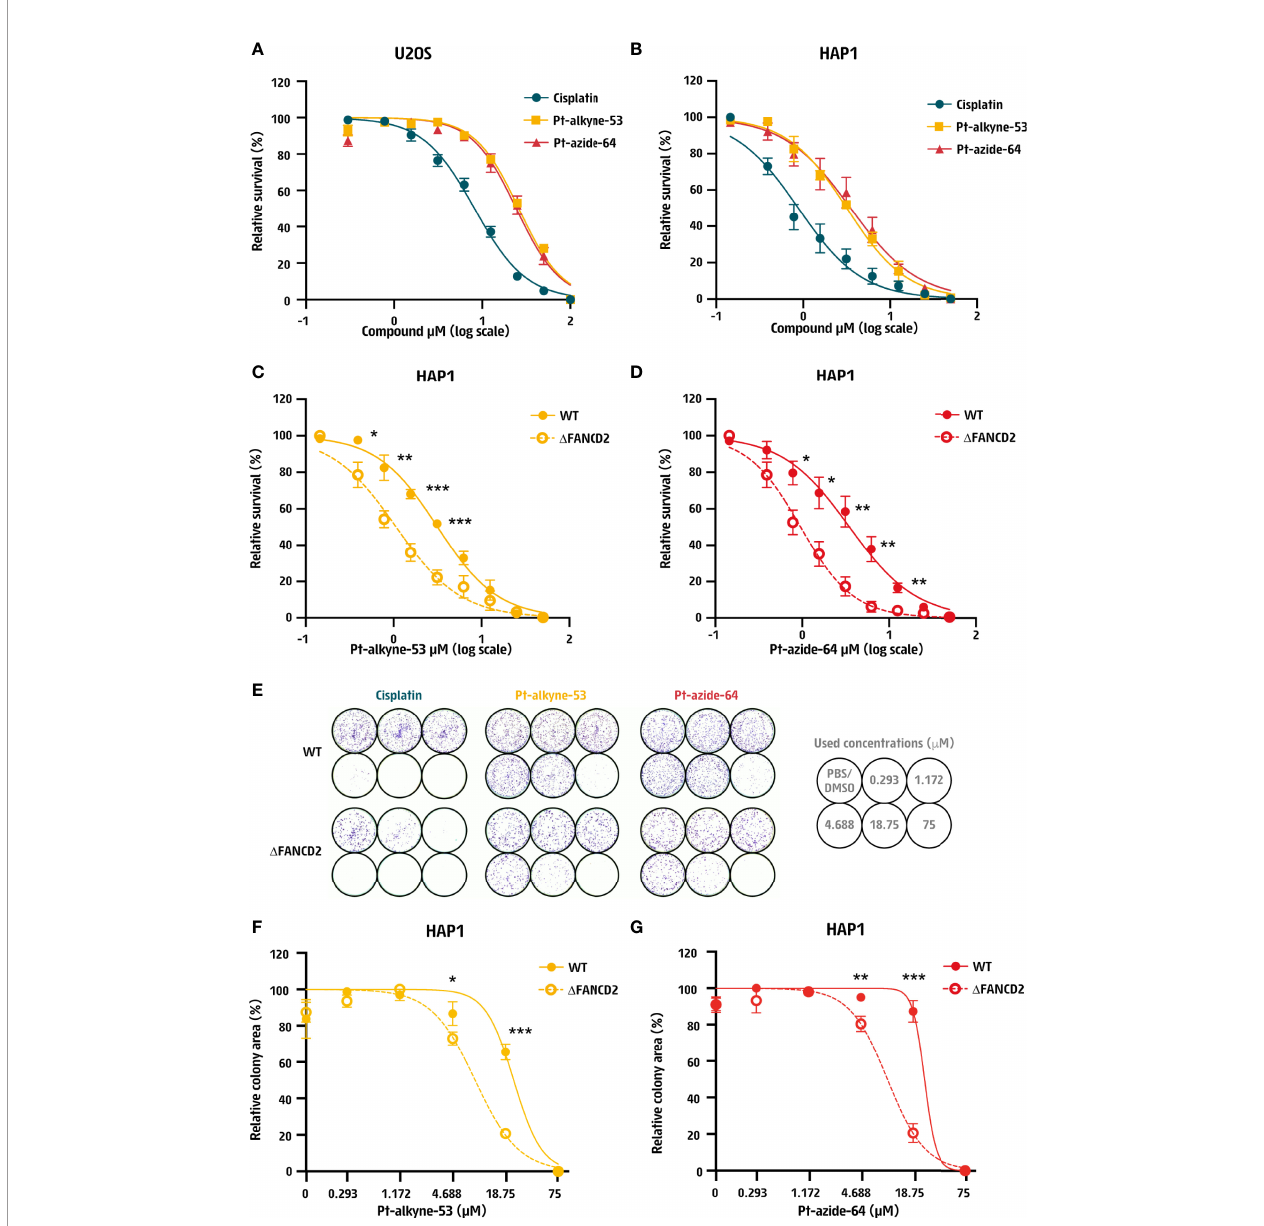
FIGURE 2 | Cisplatin derivatives confer DNA repair-dependent cytotoxicity. (A, B) Dose response curve of human (A) U2OS cells and (B) HAP1 cells treated for 3 days with cisplatin, Pt-alkyne-53 or Pt-azide-64 prepared as 2-fold serial dilutions starting at 100 m M in U2OS cells or 50 m M in HAP1 cells. Cellular survival was measured after 3 days using Cell Titer Glo ® . (C, D) Dose response curve of wildtype (WT) and FANCD2 de fi cient ( D FANCD2) HAP1 cells treated with the indicated doses of (C) Pt-alkyne-53 and (D) Pt-azide-64 for 3 days. Cellular survival was measured using Cell Titer Glo ® . Data represent mean and SEM of 3 independent experiments performed in technical duplicates. (E – G) Clonogenic assay of wildtype (WT) and FANCD2 de fi cient ( D FANCD2) HAP1 cells treated with the indicated doses of cisplatin, Pt-alkyne-53 and Pt-azide-64 for 7-8 days. (E) Representative images from 3 independent experiments and quanti fi cation of the surface area occupied by cells. (F, G) Quanti fi cation of the surface occupied by cells after treatment with (F) Pt-alkyne-53 and (G) Pt-azide-64. Data represent mean and SD of 3 independent experiments. P-values were calculated using multiple unpaired t-test. *<0.05, **<0.01,